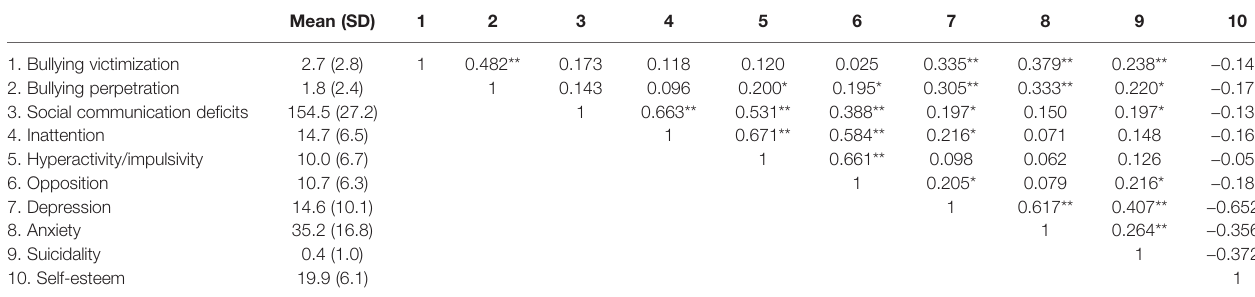
TABLE 1 | The correlation matrix of measured